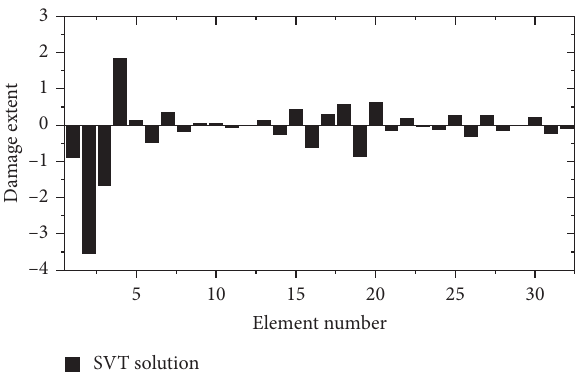
Figure 11: Damage detection result by SVT solution when element 21 is damaged.